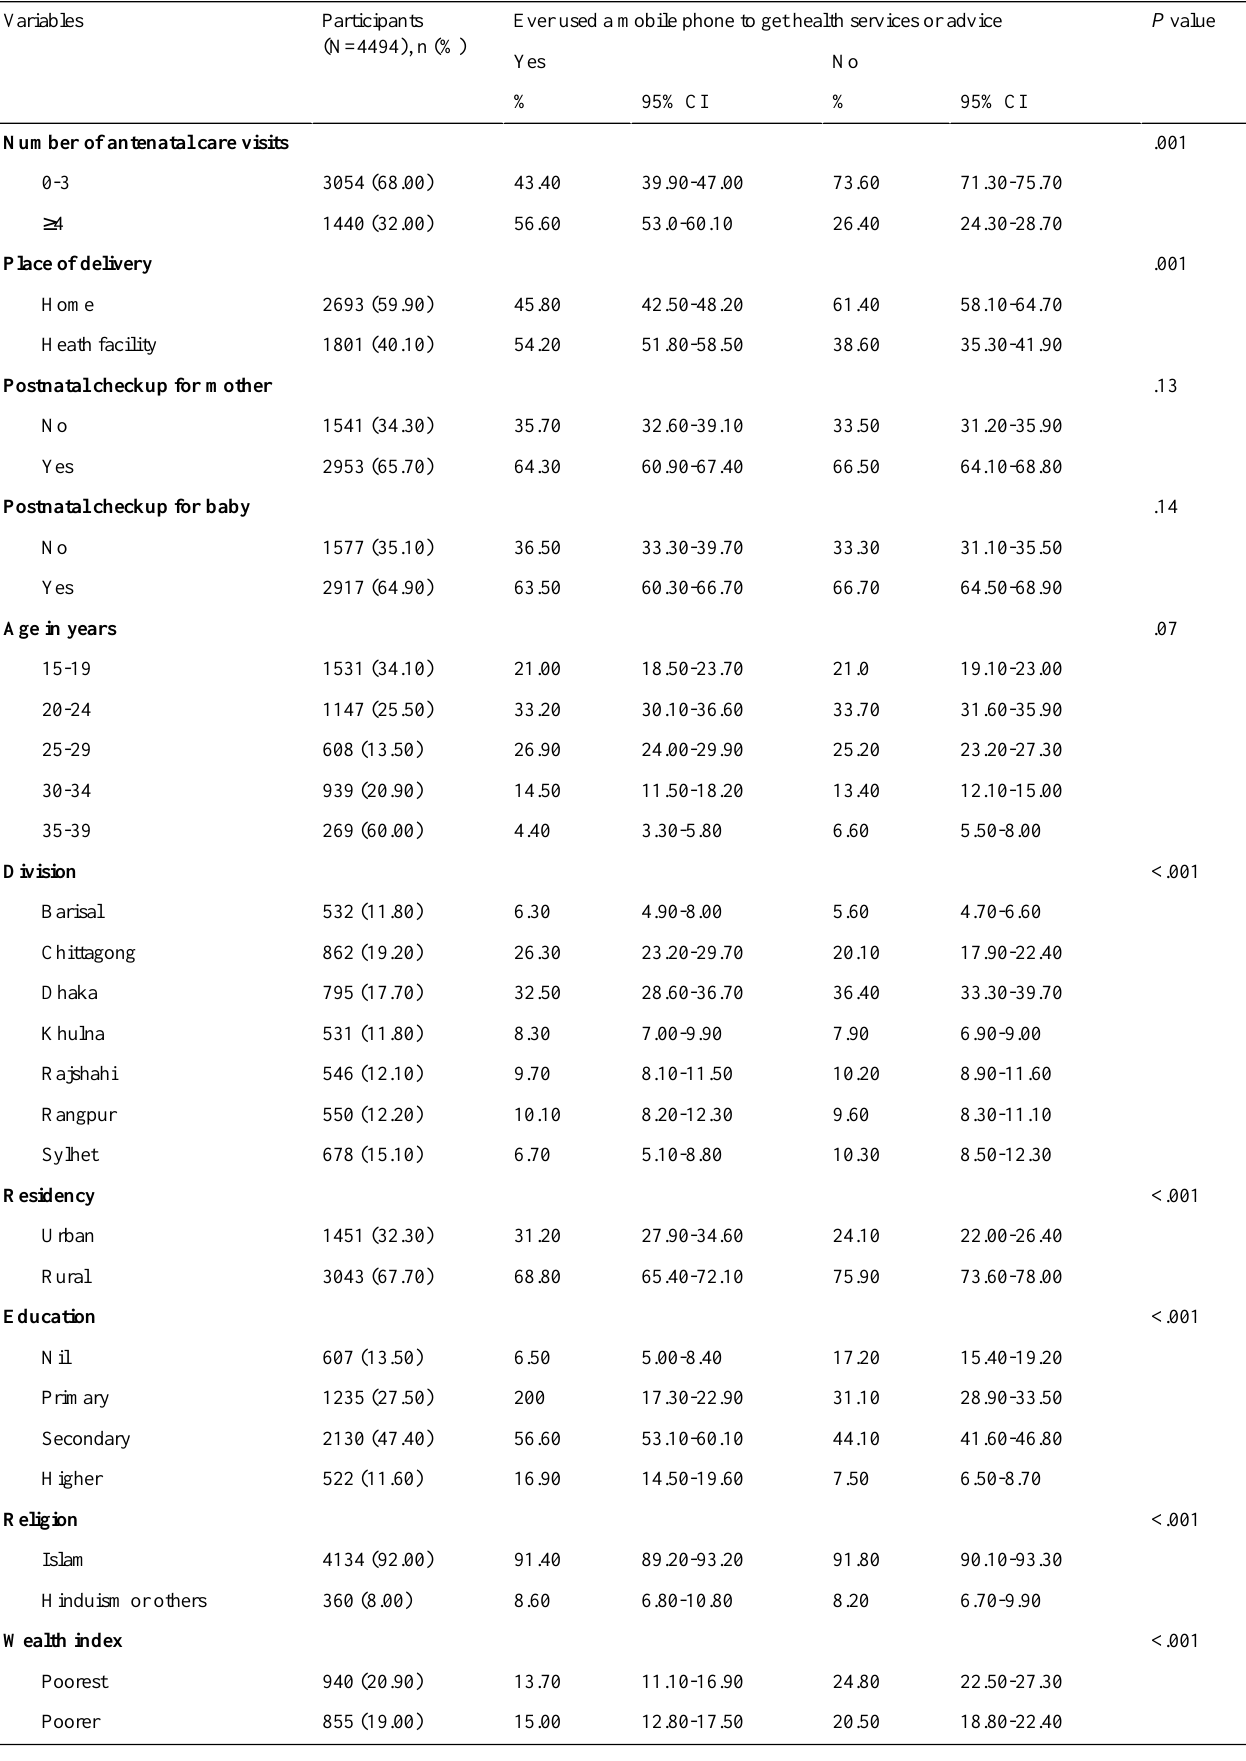
Table 2. Sociodemographic profile of the participants (N=4494). Bangladesh Demographic and Health Survey 2014. All the percentages are weighted.